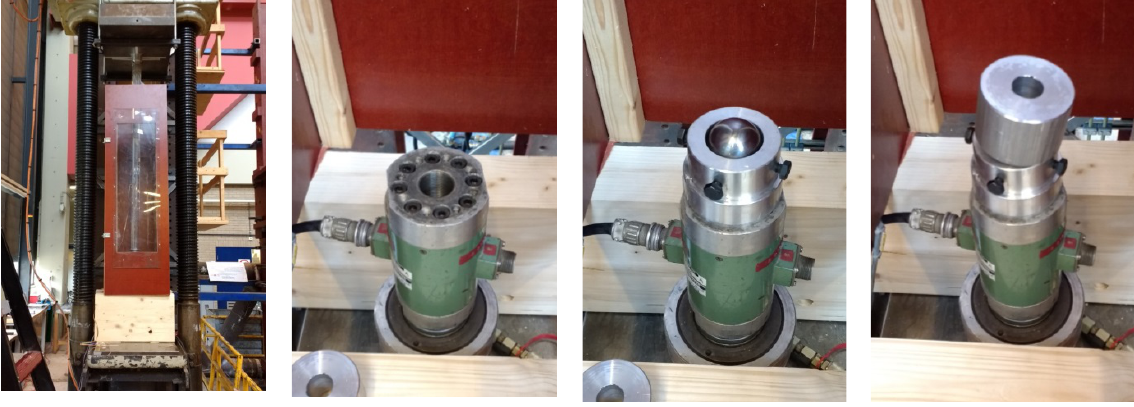
Fig. 12 Test setup Fig. 13,14,15 Hydraulic piston, force gauge, ball joint.